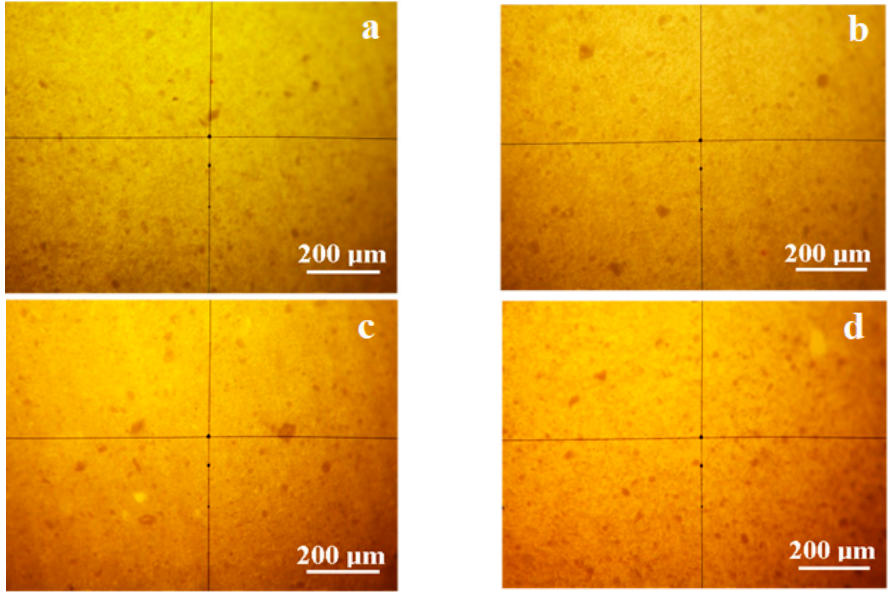
Figure 10. Cross-polarized light mineralogical microscopy images for surface layer: ( a ) control group; ( b ) rainwater; ( c ) acetic acid solution; ( d ) sulfuric + nitric acid solution. The structural layer is presented in Figure 11. The sand particles have a rounded/elongated shape with sharp edges for all samples. Most crystalline particles have a green-gray color, which is typical for quartz.